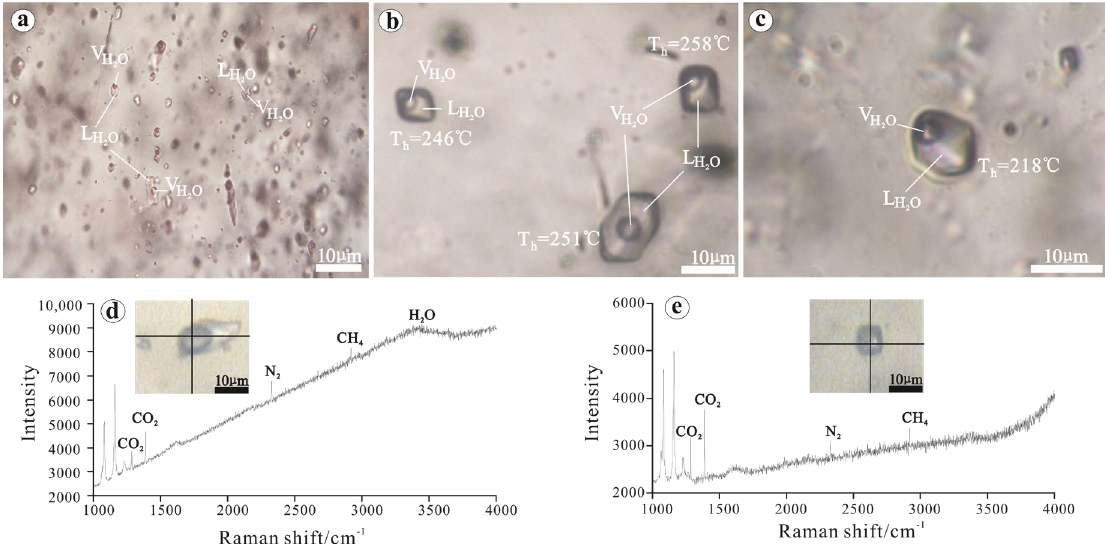
Figure 5. Microphotographs and laser Raman spectra of fluid inclusion in quartz from the Nibao gold deposit: ( a , b ) two-phase aqueous inclusions(main-stage quartz of Sbt); ( c ) two-phase aqueous inclusions (main-stage quartz of fault F1); ( d ) two-phase aqueous inclusions containing CO 2 , N 2 , and CH 4 ; ( e ) CO 2 inclusions containing N 2 and CH 4 .